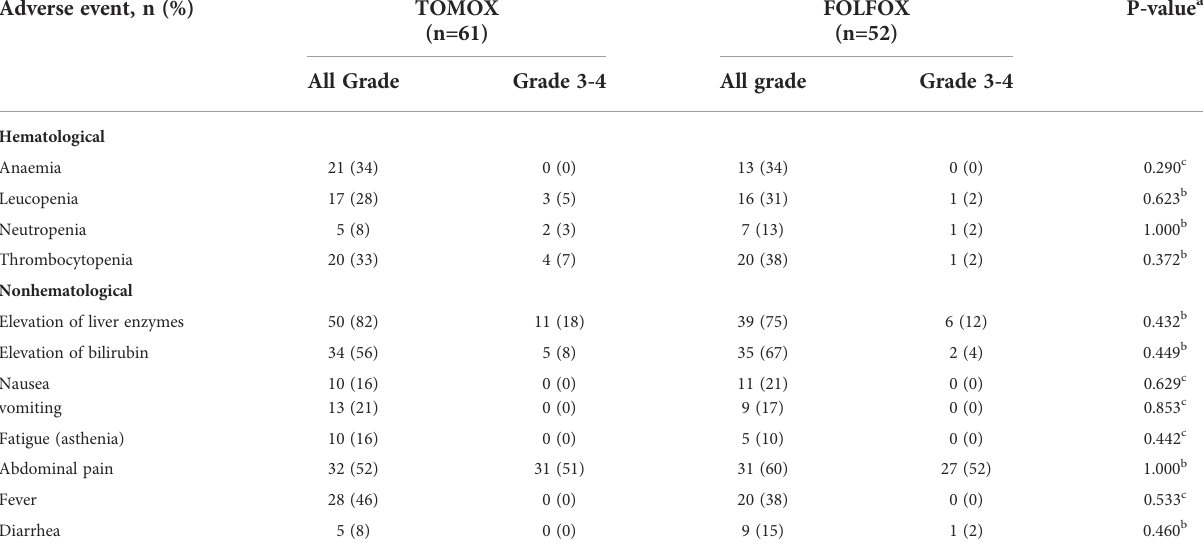
TABLE 4 Summary of safety